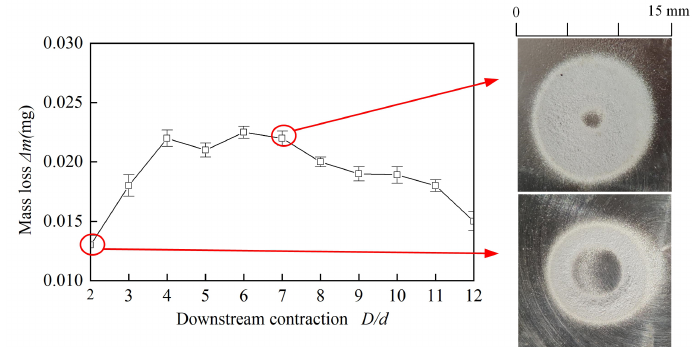
Figure 8. Mass loss and macroscopic appearance as a function of downstream contraction ratio D / d